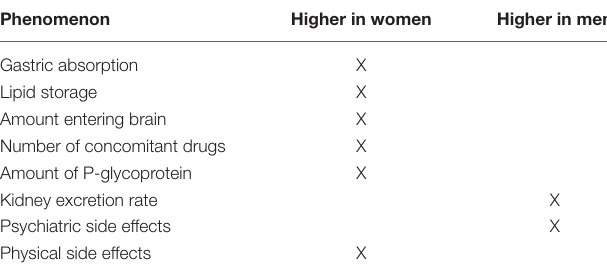
TABLE 1 | Sex/gender and antipsychotic effects. Phenomenon Higher in women Higher in